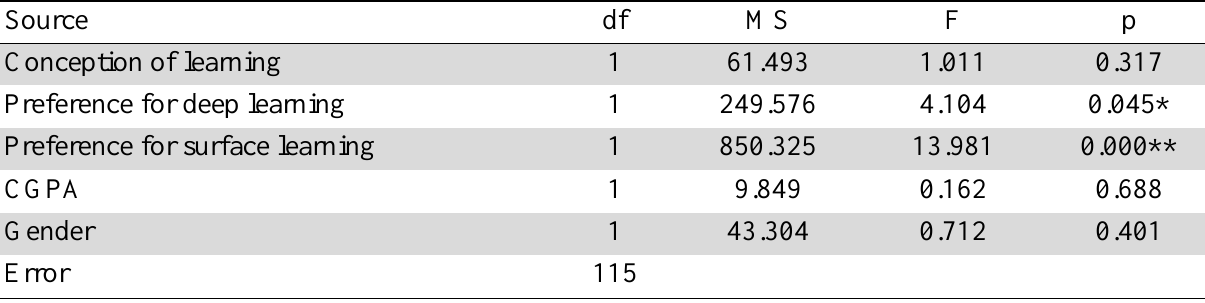
ANCOVA for surface